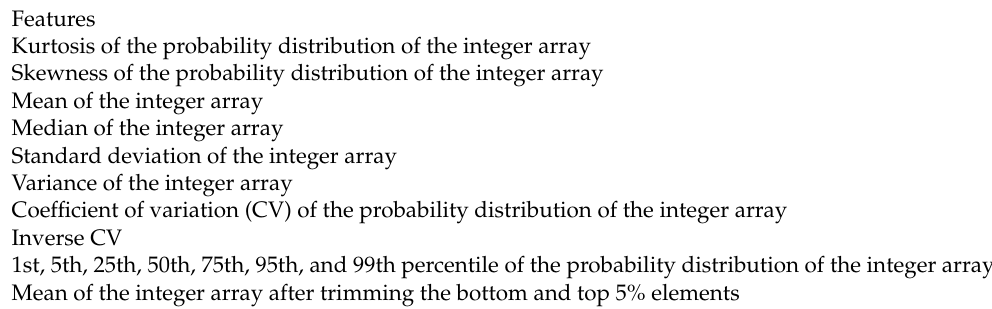
Table 4. Statistical features that were extracted from each